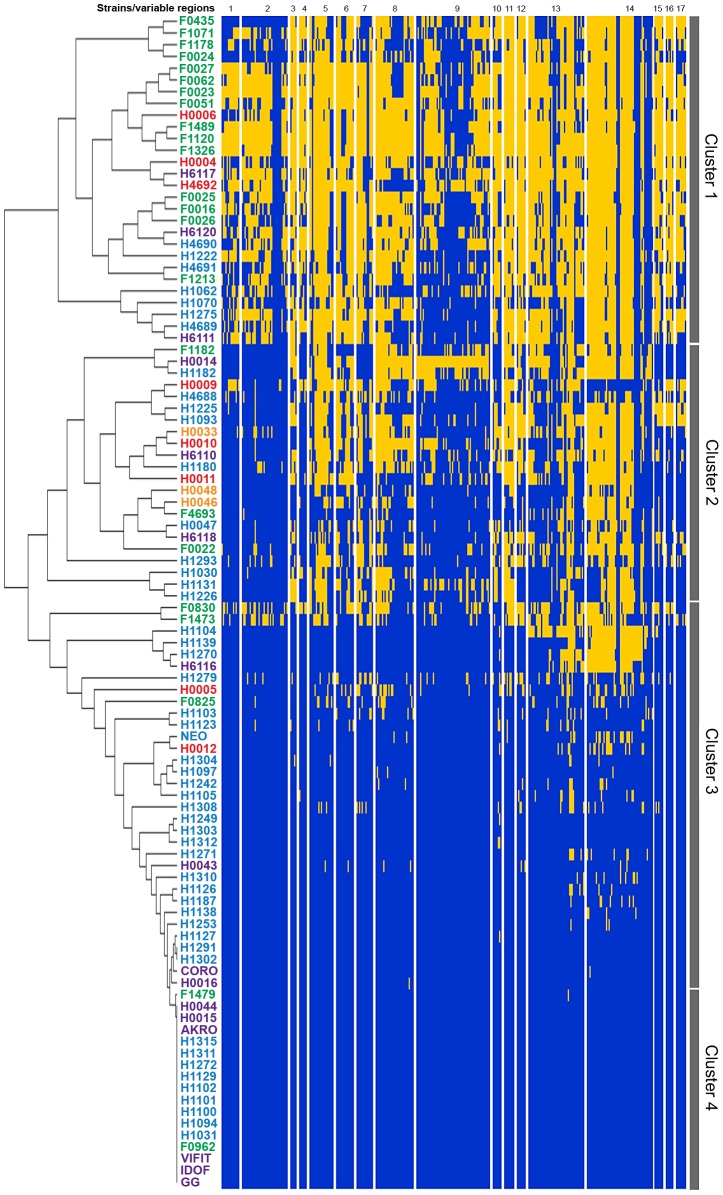
Analysis of genome diversity in L. rhamnosus by mapped SOLiD sequencing.The 100 L. rhamnosus strains were clustered using hierarchical clustering [78] based on their relative shared gene content with L. rhamnosus GG. Strain names were colour-coded as follows: green for dairy isolates, purple for intestinal isolates, orange for oral isolates, magenta for vaginal isolates and blue for clinical/other isolates. Four main groups or clusters were highlighted and numbered. The Figure 1 also shows the 17 variable chromosomal regions identified in GG, as further detailed in Table 1. Each row corresponds to one strain, and each column shows the genes in these variable regions, colour-coded as follows: blue for present and yellow for absent.